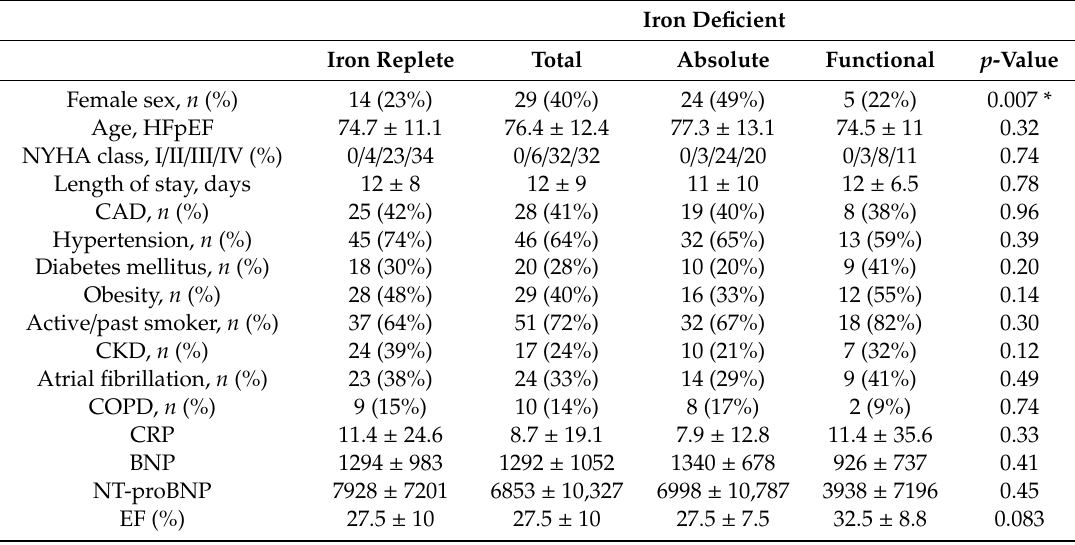
Table 3. Patient characteristics, biomarker levels and diastolic function indices on TTE according to iron status in the heart failure with reduced ejection fraction (HFrEF)